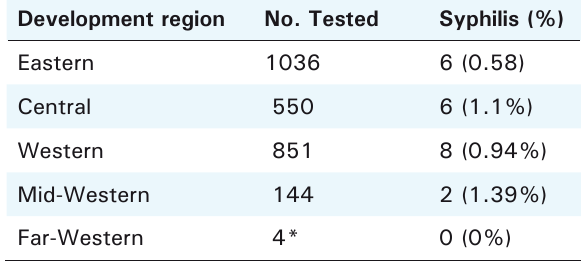
table 2. Distribution of syphilis in different development